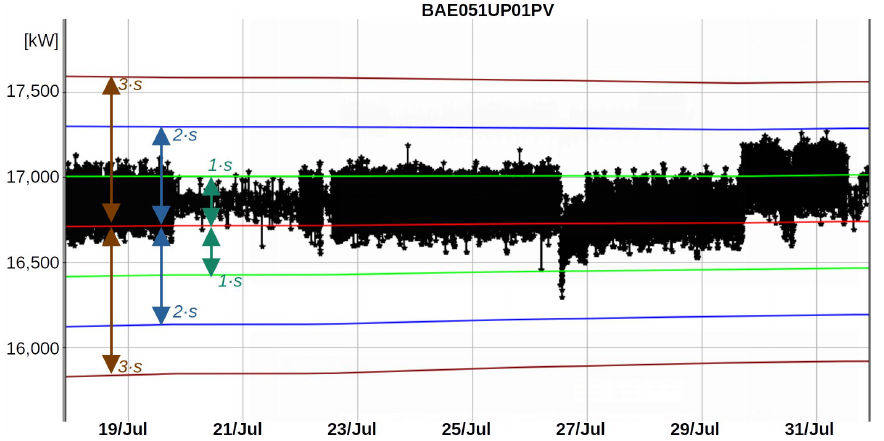
Figure 4. Control chart of active power of the generation unit 05 between 17 July 2019 and 31 July